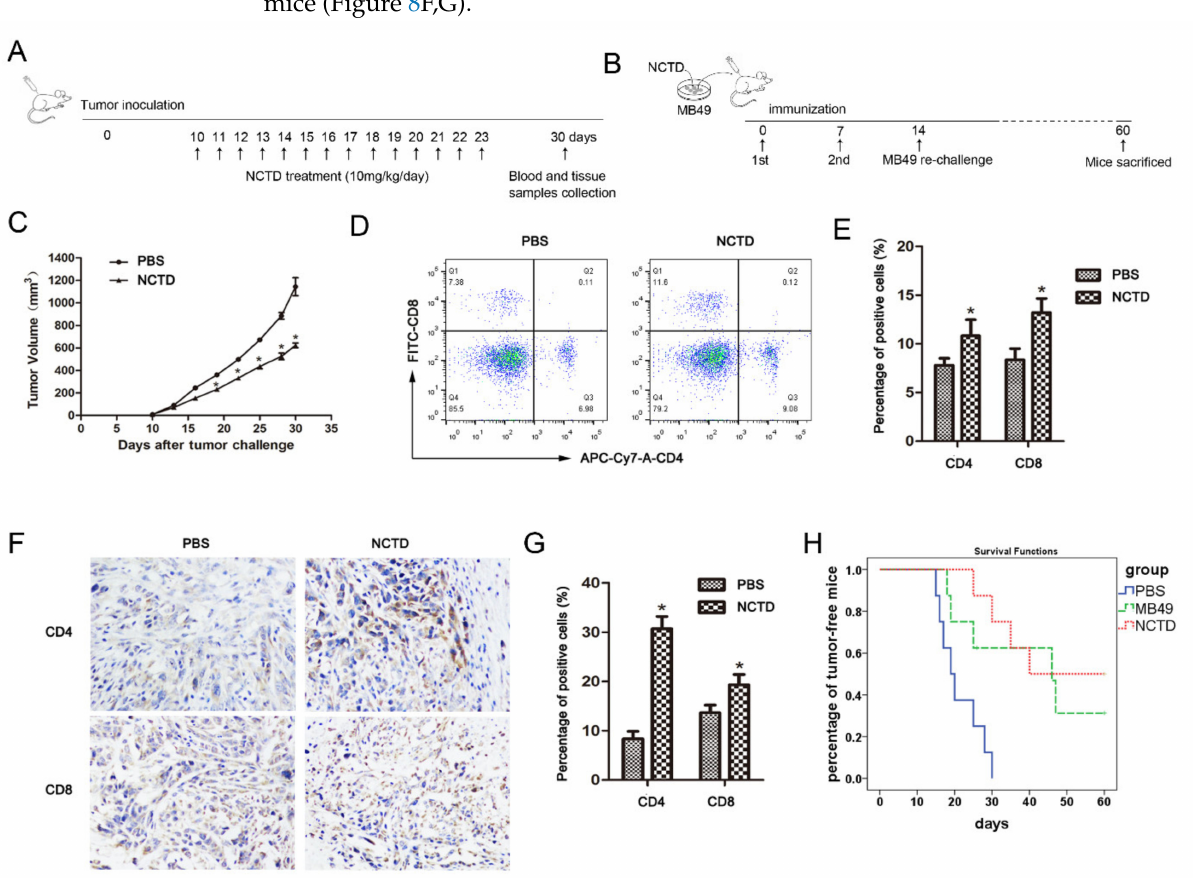
Figure 8. NCTD improves antitumor immunity in mice. ( A ) The in vivo immunomodulatory activity of NCTD was tested by MB49 mouse bladder cancer model. ( B ) The in vivo tumor immunization assay was performed by using NCTD-treated MB49 cells as a “tumor vaccine”. ( C ) Tumor volumes of MB49 cell xenograft mice in ( A ) model. ( D , E ) Blood samples were collected from mice and stained with APC-Cy7-A-labeled anti-mCD4 or FITC-labeled anti-mCD8 antibody. The percentage of CD4 + T or CD8+ T in the ( A ) model was analyzed by flow cytometry. ( F , G ) Immunohistochemistry and quantitative analyses of CD4 + T and CD8 + T in the tumor tissues in ( A ) model. Data are presented as the mean ± SD ( n = 3), * p < 0.05 vs. the control group. ( H ) Tumor-free survival analysis by Kaplan– Meier curves of mice immunized with NCTD-treated MB49 cells in ( B ) model. The experiment was repeated